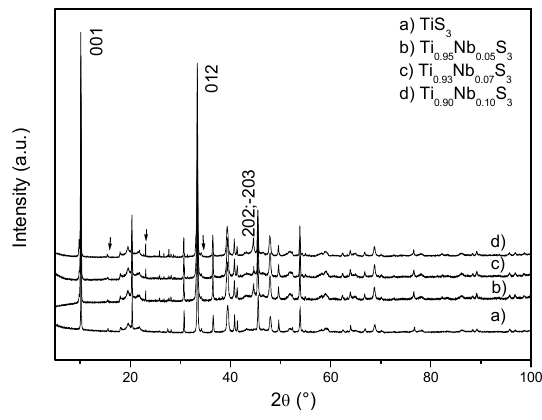
Figure 2. X-ray diffraction (XRD) patterns of Ti 1 − x Nb x S 3 ( x = 0, 0.05, 0.07, 0.10) samples obtained after Spark Plasma Sintering (SPS). Relevant hkl index are given. Arrows show extra peaks of unreacted pure